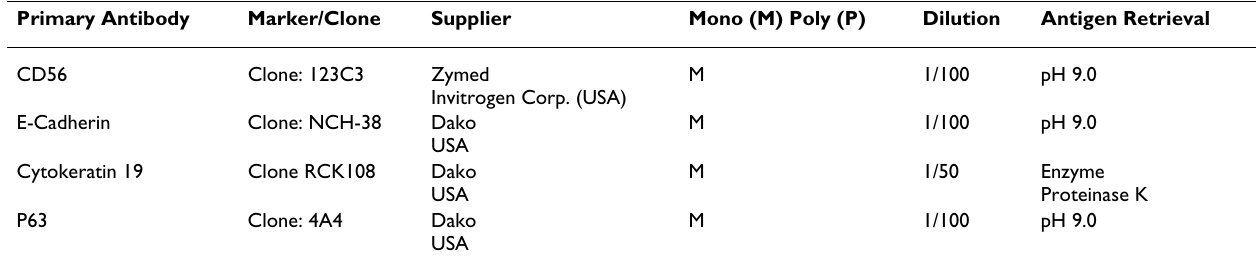
Table 1: Properties of immunhistochemical antibodies used in the study Primary